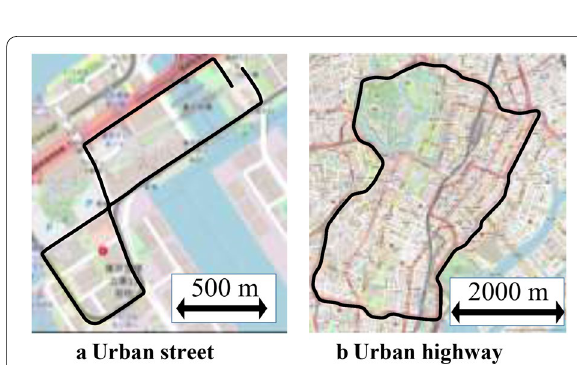
Fig. 8 Evaluation fields [“© OpenStreetMaps”]